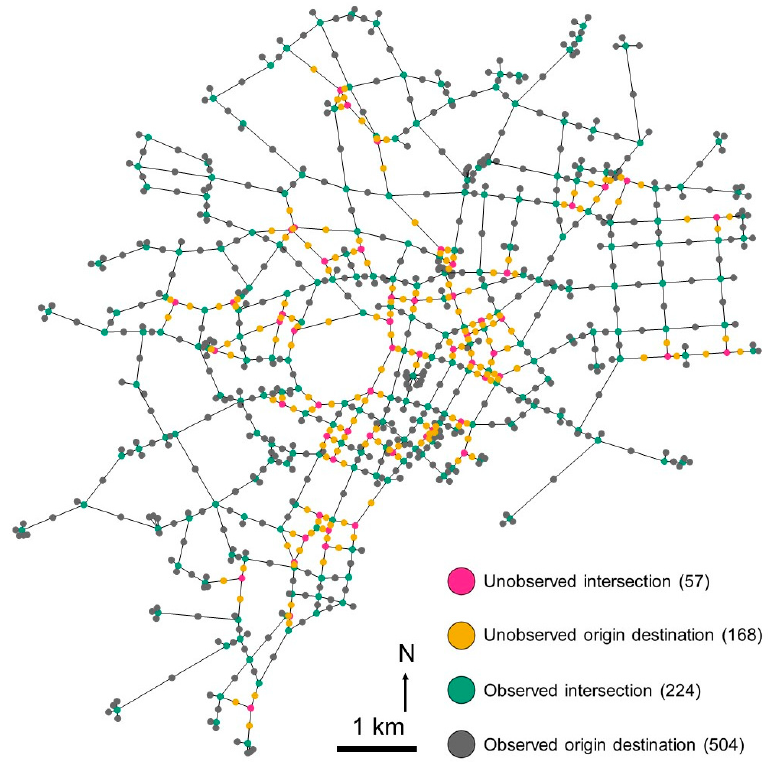
Figure 3. Road graph. A total of 57 unobserved intersections were added to create the whole road graph.